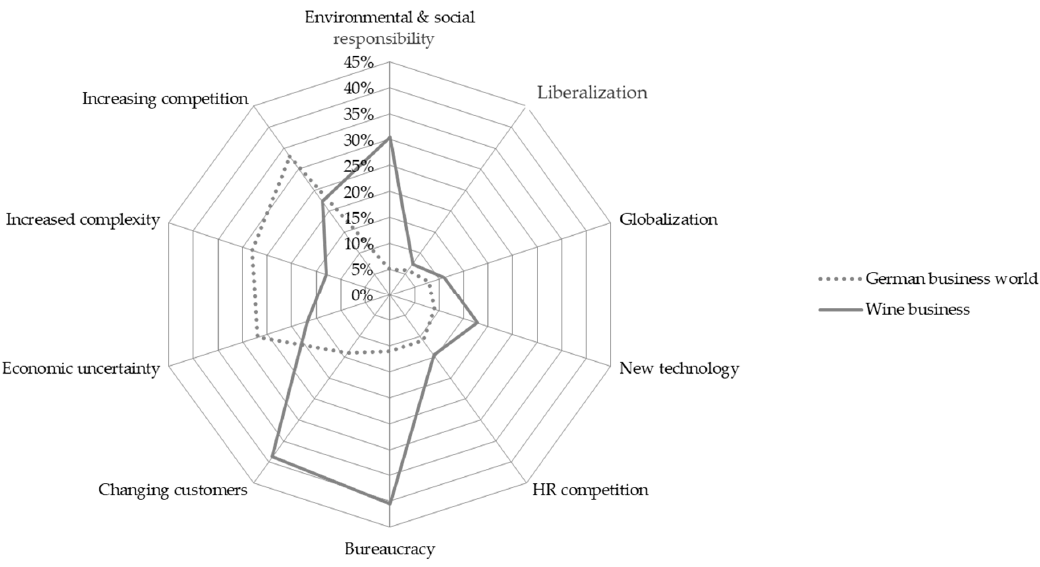
Figure 7. Environmental perception (survey results [131]).